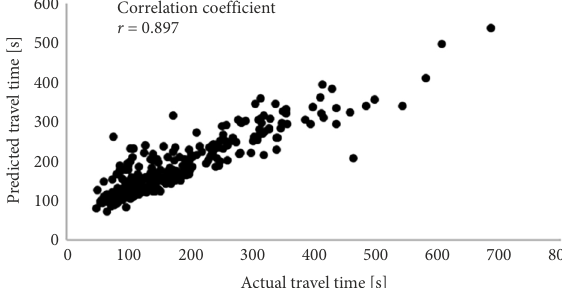
Figure 5. Sample scatter plot of actual vs. predicted travel times (temporal SVM)